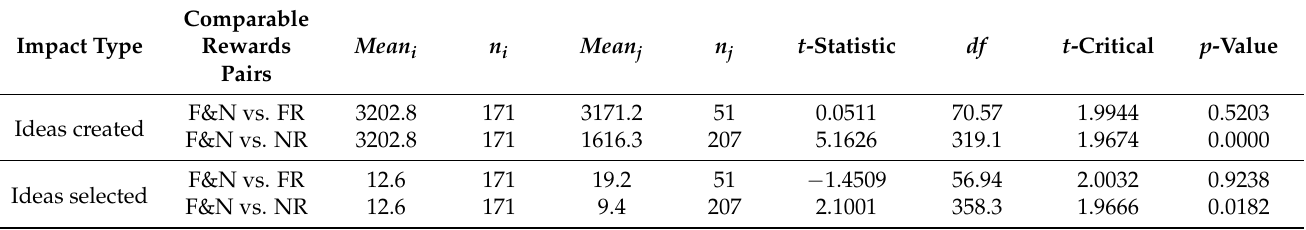
Table 10. Hypothesis test statistics for mixed rewards comparison with non-financial and financial rewards.